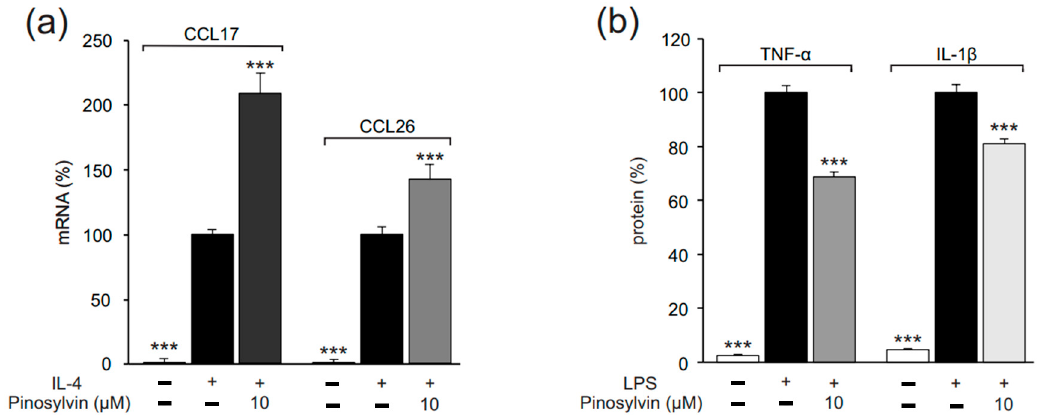
Figure 8. Pinosylvin shifted macrophage polarization towards alternative M2 phenotype in U937 human macrophages. U937 cells were cultured with IL-4 (10 ng/mL, a ) or LPS (10 ng/mL, b ) alone, or together with pinosylvin for 24 h. Expressions of C-C motif chemokine ligand 17 (CCL17) and C-C motif chemokine ligand 26 (CCL26) mRNA were measured by quantitative reverse transcriptase polymerase chain reaction (qRT-PCR) and normalized against GAPDH mRNA ( a ). Tumor necrosis factor α (TNF- α ) and interleukin-1 β (IL-1 β ) concentrations in the culture media were measured by enzyme-linked immunosorbent assay (ELISA, b ). The results are expressed as mean + SEM, n = 6 ( a ) or n = 4 ( b ). Statistical significance of the results was calculated by one-way ANOVA followed by Bonferroni multiple comparisons test. *** = p < 0.001 as compared to cells stimulated with IL-4 ( a ) or LPS ( b ) only, marked as a black